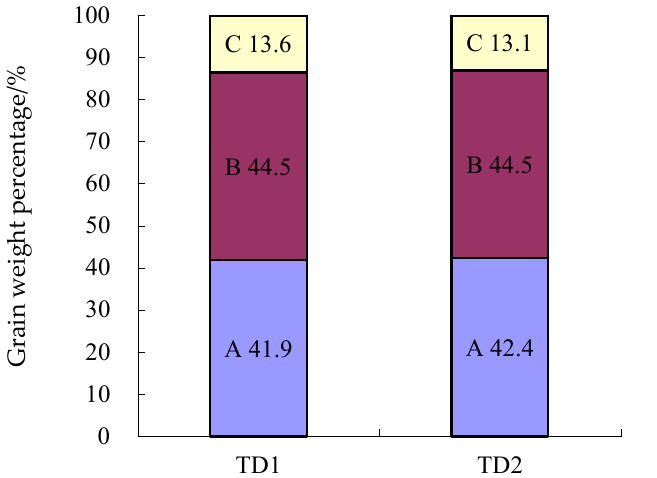
Figure 8. Threshing amount statistical comparison in different sections of two types of drums.